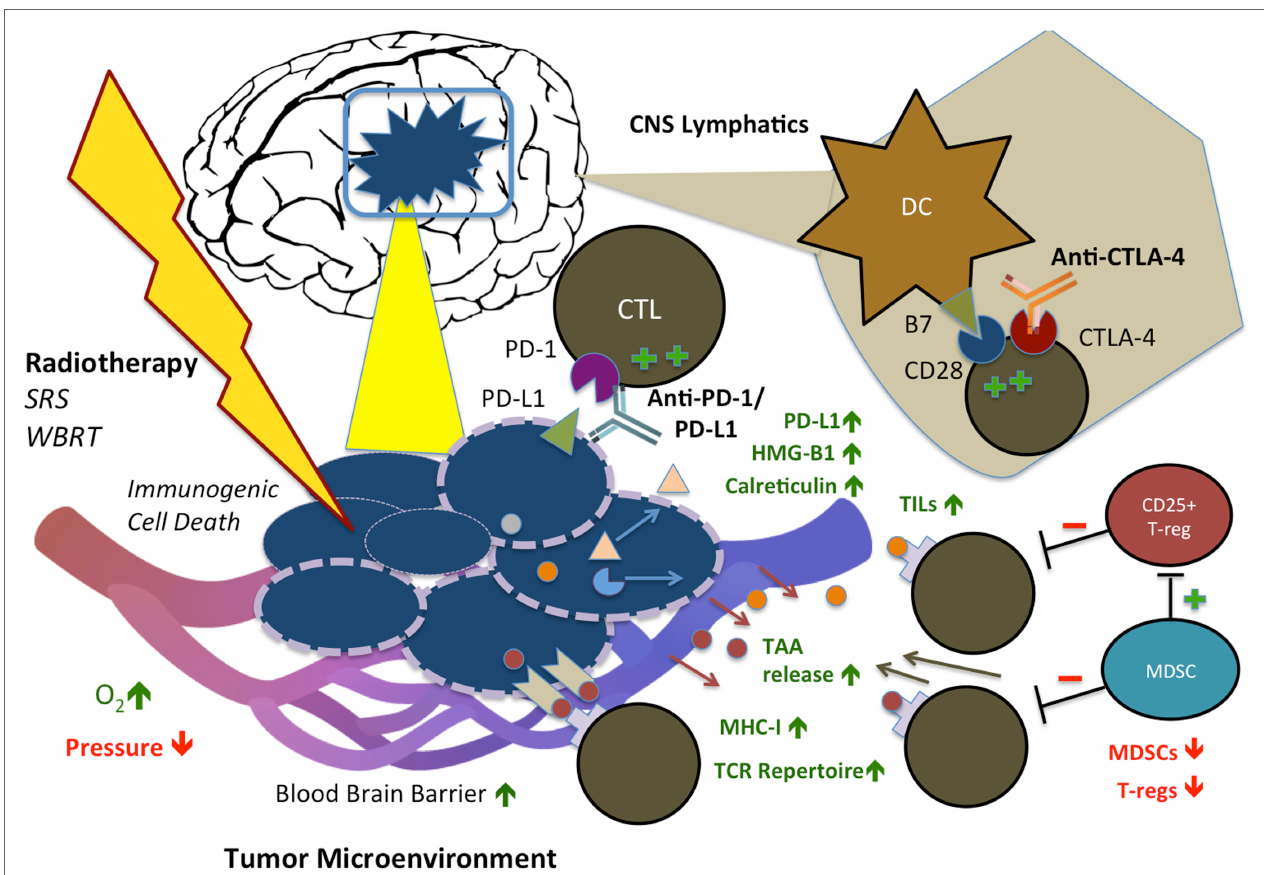
FiGURe 1 | immunostimulatory effects of radiation therapy (RT) in combination with immune checkpoint blockade (iCB) in the CnS . RT and ICB work synergistically to create an immunogenic tumor microenvironment and promote systemic antitumor response. Anti-PD-1 and PD-L1 agents reduce tumor cell-mediated exhaustion signals to CD8 + CTLs, while anti-CTLA-4 agents block competing co-inhibitory activity of CTLA-4, resulting in increased and persistent T-cell activation. RT triggers immunogenic cell death (ICD) of tumor cells, displacement of calreticulin (CRT) to the cell surface, release of HMG-B1, increased MHC-I expression, and release of tumor-associated antigens (TAAs), with consequent increase in TCR repertoire of infiltrating T-cells. In addition, RT has stromal effects on the tumor microenvironment: increasing oxygenation, infiltration of TILs, and permeability of the blood–brain barrier (BBB), while decreasing interstitial fluid pressure. In combination with ICB, RT also reduces activity of T-regs and MDSCs. SRS, stereotactic radiosurgery; WBRT, whole brain radiation therapy; CTL, cytotoxic T-lymphocyte; PD-1/L1, programmed cell death protein 1/ligand 1; CTLA-4, cytotoxic T-lymphocyte-associated protein 4; DC, dendritic cell; TIL, tumor-infiltrating lymphocyte; TAA, tumor-associated antigen; MHC, major histocompatibility complex; TCR, T-cell receptor; MDSC, myeloid-derived suppressor cell; HMG-B1, high mobility group box